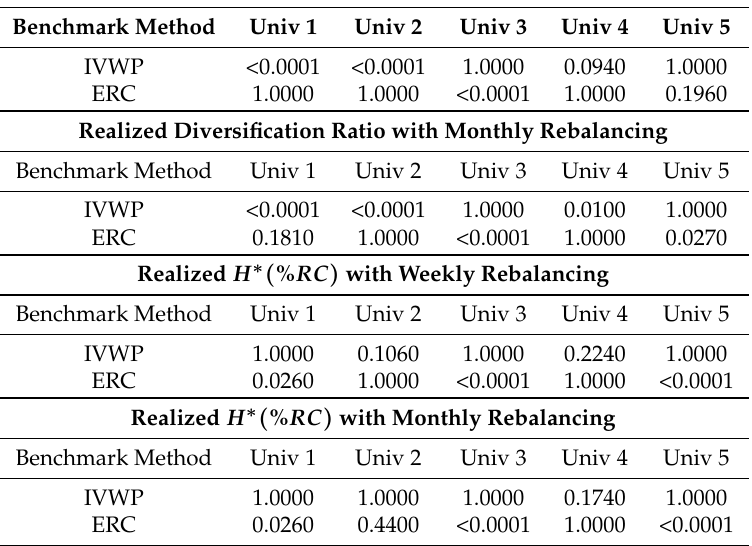
Table A5. p c -value for different choices of benchmark model based on the out-of-sample H ∗ ( % RC ) and diversification ratios, when different rebalancing horizons are considered. The covariance forecast model is taken as